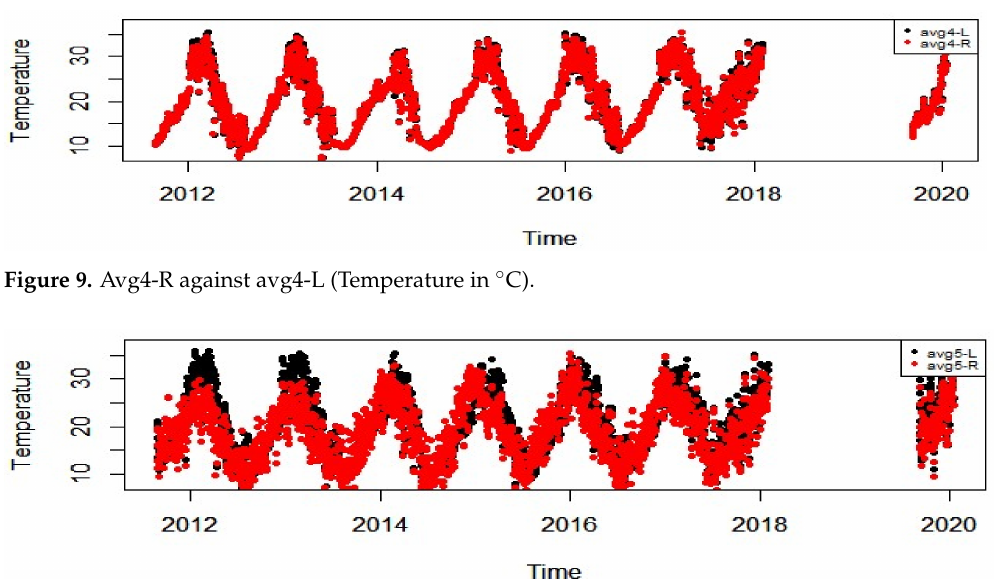
Figure 8. Avg3-R against avg3-L (Temperature in ◦ C).